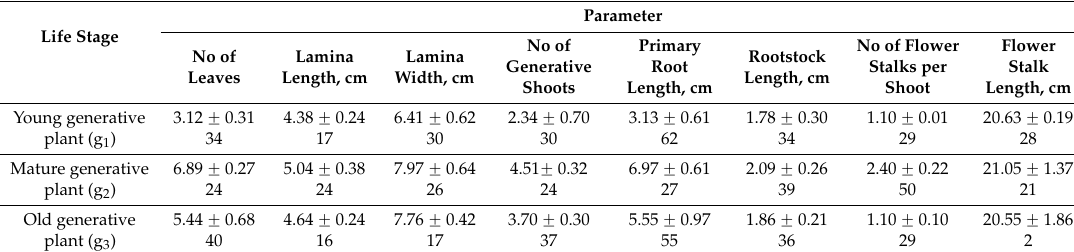
Table 3. Morphological characteristics of generative individuals (g 1 –g 3 ) of Anemone patens ( n = 15 for each life sub-stage). In the numerator is the mean ( ¯ X ) and its standard error ( ˘ SE ), and in the denominator the coefficient of variation (% CV